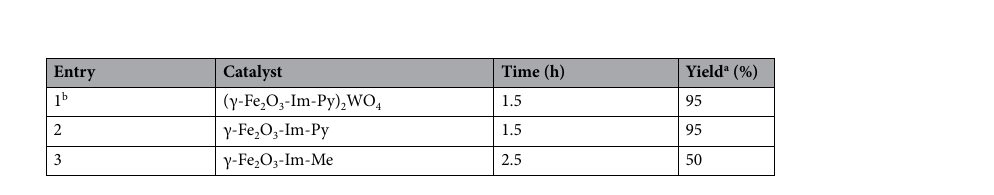
Table 7. The effect of different catalysts in the synthesis of 2-amino-3-cyano-4 H -chromene from benzaldehyde. a Reaction conditions: benzaldehyde (1 mmol), malononitrile (1.2 mmol), dimedone (1.2 mmol), catalyst (142 mg), neat, 90 °C. b Amount of the catalyst (5 mol%, 142 mg) is based on W content and relative to